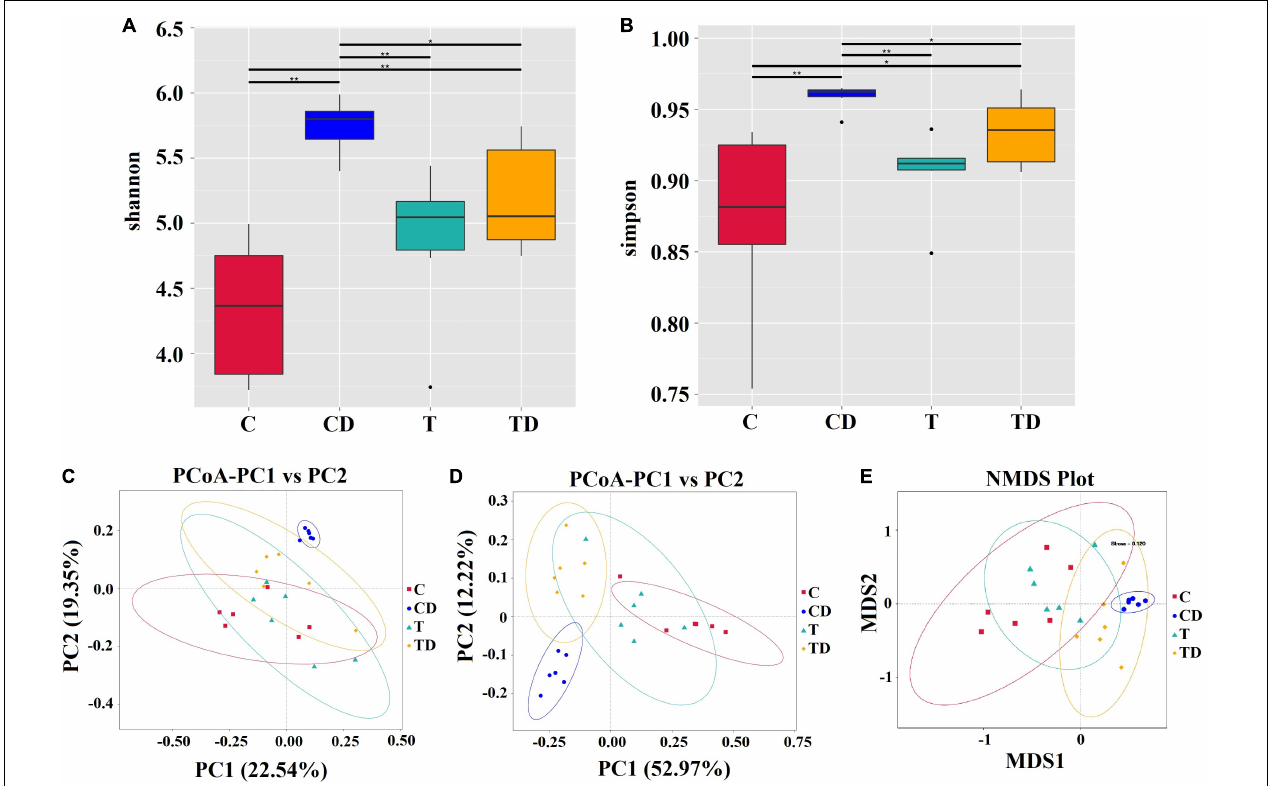
FIGURE 3 | Differences in the cecal microbiota of mice. (A,B) The diversity and richness of the microbiota of mice in different groups were measured by the Shannon (A) and Simpson (B) indices. Asterisk above the box plots indicates significant differences between age groups (Wilcoxon rank-sum test: * p < 0.05, ** p < 0.01). (C,D) Principal coordinates analysis (PCoA) of microbial communities based on weighted (C) and unweighted (D) Unifrac distances. (E) Non-metric multidimensional scaling analysis.